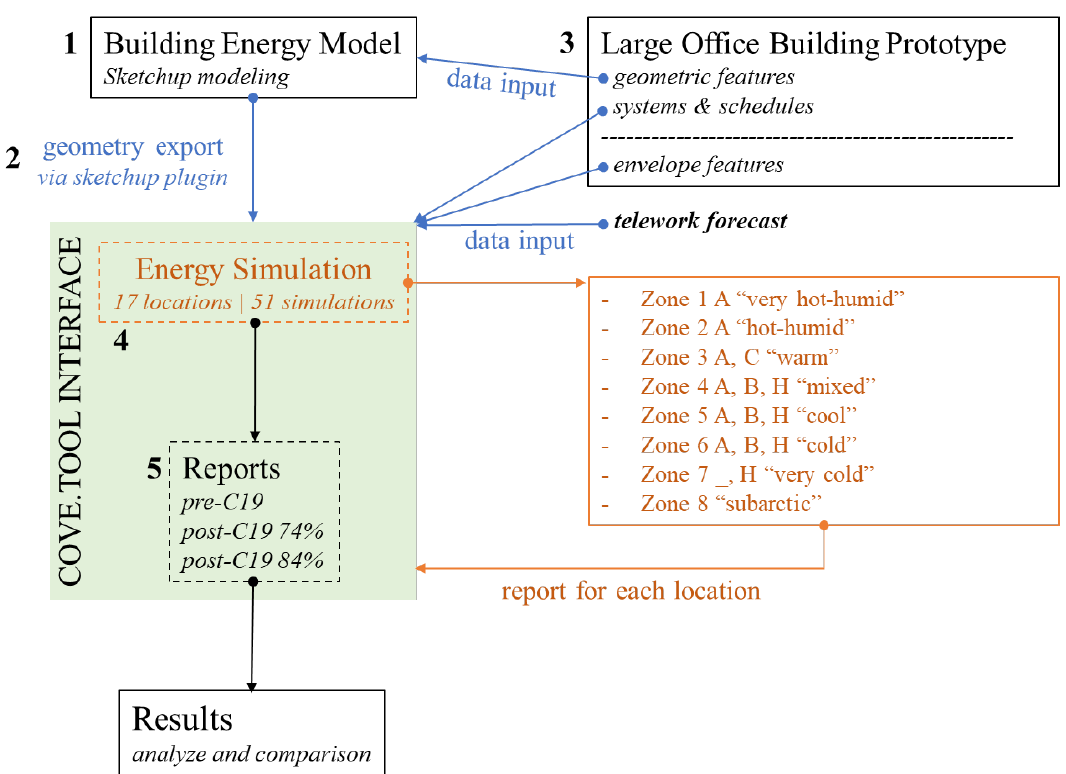
Figure 1. Diagram of the five-step methodology.